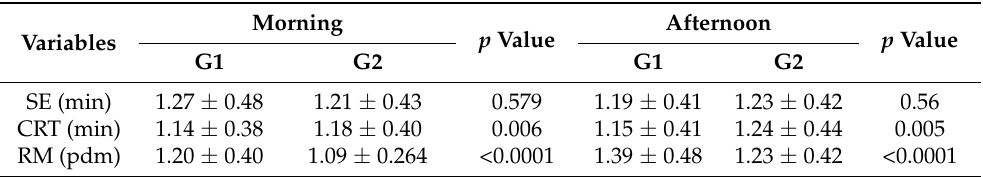
Table 4. Effect of time of day (morning and evening) on skin elasticity (SE), capillary return time (CRT), and rumen movements (RM) in ewes.